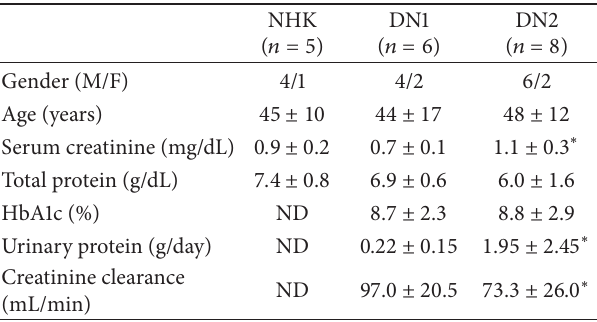
Table 1: Baseline